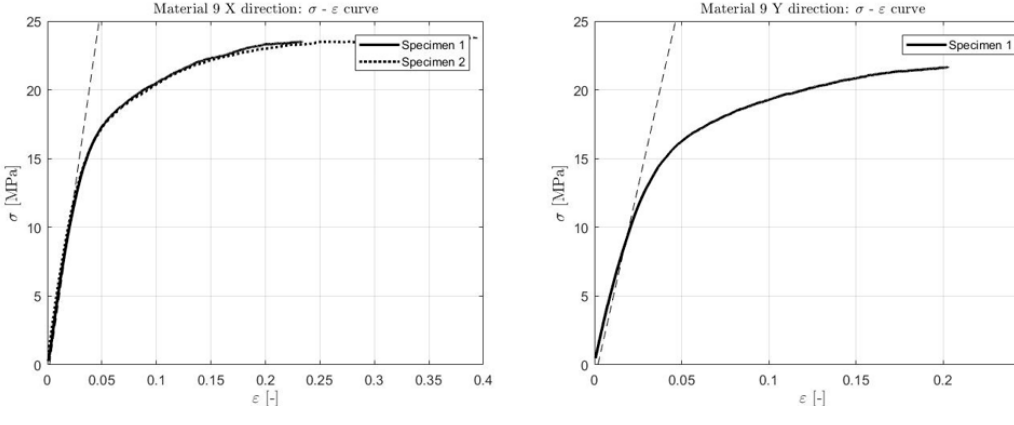
Figure 7. Material 9 tensile tests.